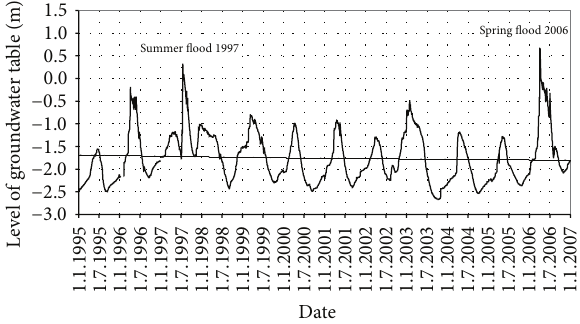
Figure 4: Development of daily averages of the groundwater table level1995–2006inthemonitoringsiteRanˇspurkinthelocalityofthe forest district Soutok in the confluence floodplain of the Morava and